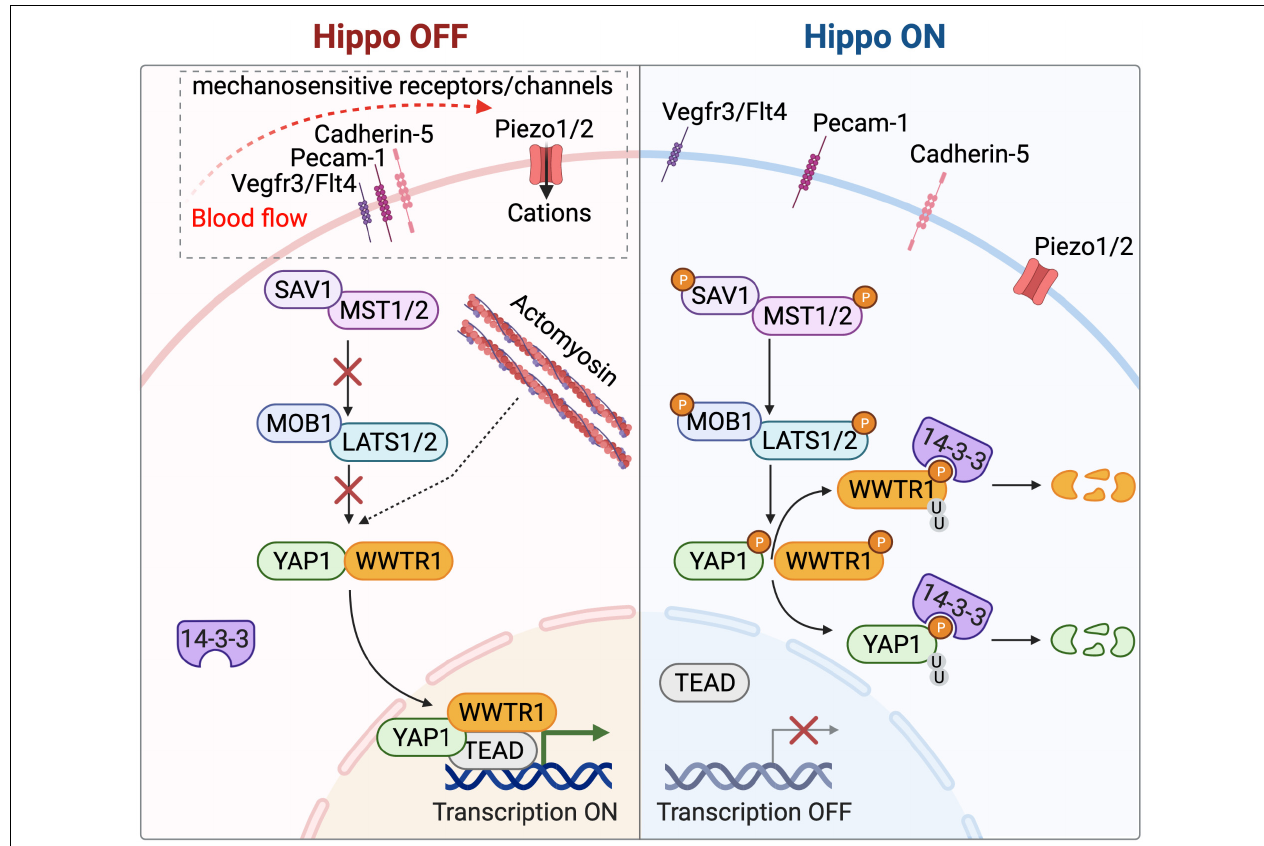
FIGURE 1 | Biomechanical Hippo signaling pathways in the zebrafish endocardium. Biomechanical forces are sensed and transmitted by the mechanosensitive protein Cadherin-5 (Cdh5) and Piezo1/2 ion channels. This turns the Hippo signaling pathway to an inactive state (right) and results in the nuclear translocation of unphosphorylated YAP1/WWTR1 transcription factors where they form a complex with TEAD transcription factors to regulate gene expression. In the absence of biomechanical stimuli, the Hippo signaling pathway is active (left). This initiates a cascade of phosphorylation events on MST1/MST2 and LATS1/LATS2 kinases, which phosphorylate YAP1/WWTR1 proteins that are retained in the cytoplasm or become proteolytically degraded.